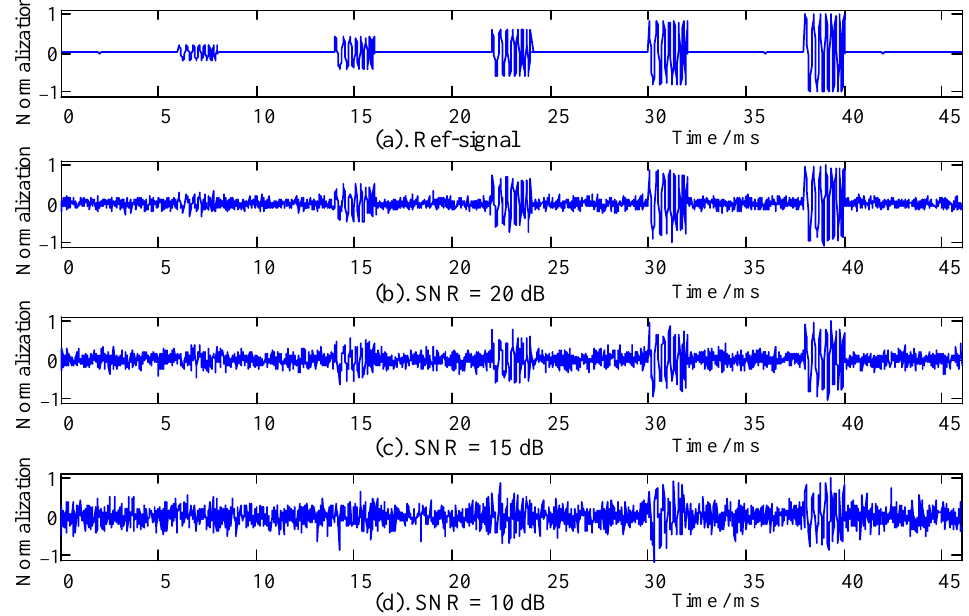
Figure 4. Simulated signals with different SNRs. ( a ) Simulated reference signal. ( b – d ) The back- ground noise with different SNRs of 20, 15, and 10 dB, respectively.